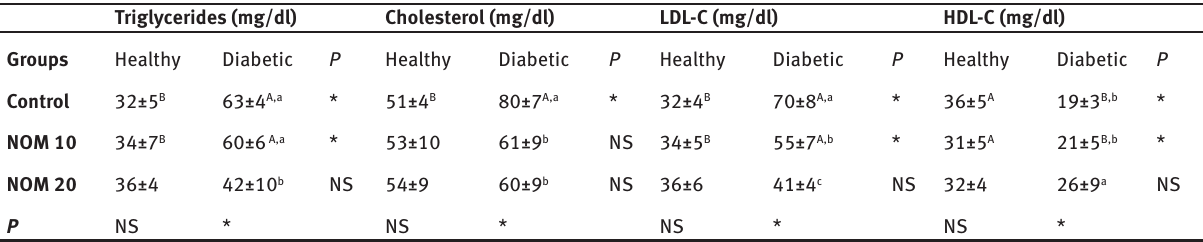
Table 3: Effects of Nannochloropsis oculata microalgae (NOM) at rates of 10 and 20mg.kg -1 of body weight on the serum concentrations of triglycerides, cholesterol or LDL-C and HDL-C in healthy and diabetic rats.